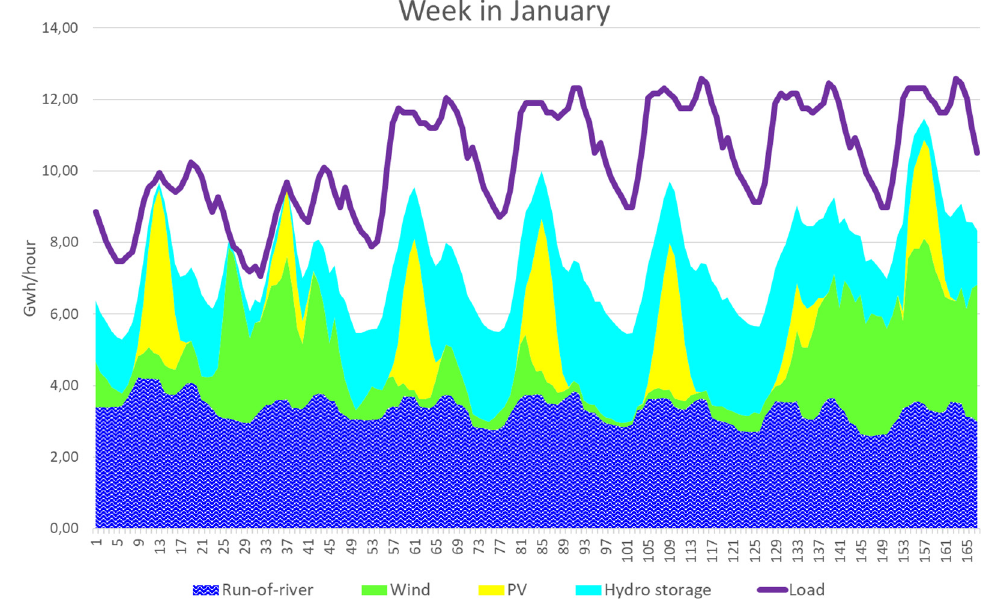
Fig. 7. January 2030: Modeling variable renewable energy sources, and electricity load during a week in 2030 in winter in Austria.